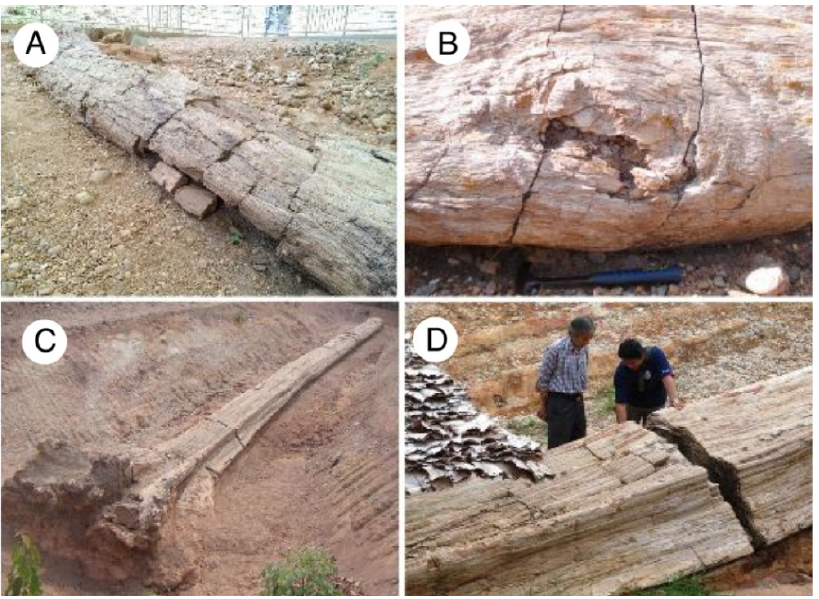
Figure 18. Transverse fractures in Tak logs. ( A , B ) BT-1. ( C , D )